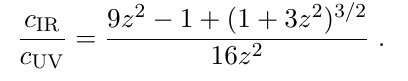
Figure 2 . Left : numerical solutions for (cid:30) ( r ) (red solid line) and dashed red/blue lines are the values for the scalars at the IR N = 2 AdS 5 vacuum at r ! (cid:0)1 . The UV N = 2 AdS 5 vacuum is at r ! 1 with (cid:30) = (cid:26) = 2. Right : a contour plot of the superpotential as a function of the scalars axis) and (cid:30) (vertical axis) together with a parametric plot of the numerical solution for the scalars from the left